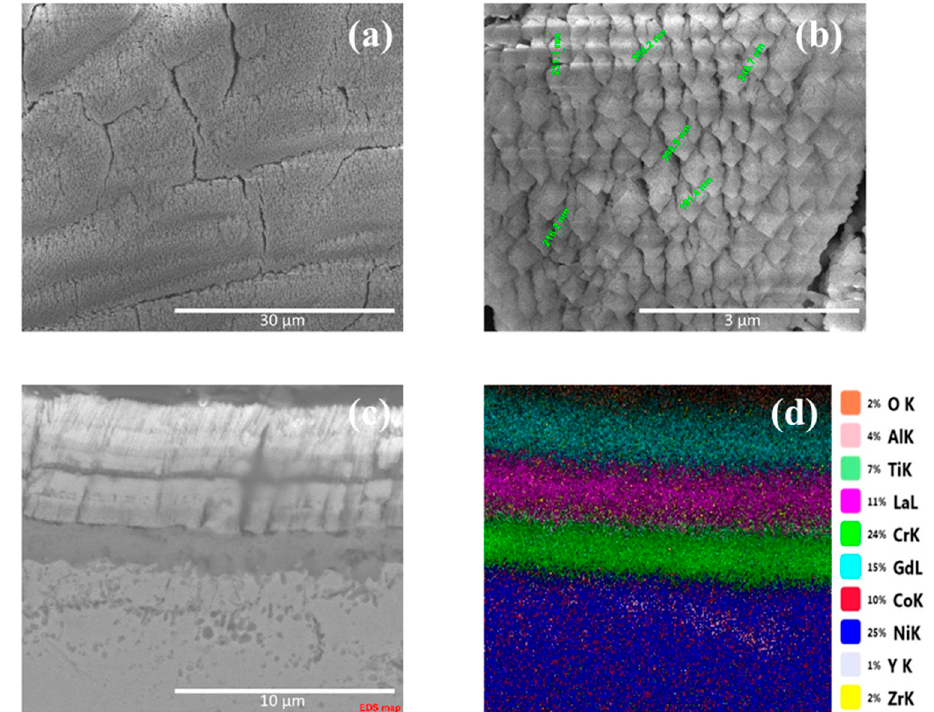
Figure 7. SEM images (QUANTA INSPECT F50, FEI Company, Eindhoven, The Netherlands) representing ( a ) and ( b ) the surface of the NiCrAlY/ZrO2-RE1/LZO/GZO multilayer coating on the Nimonic substrate after heat treatment at 1250 °C (40,000×); ( c ) cross section of the NiCrAlY/ZrO2-RE1/LZO/GZO on Nimonic substrate; and ( d ) elemental mapping after heat treatment.